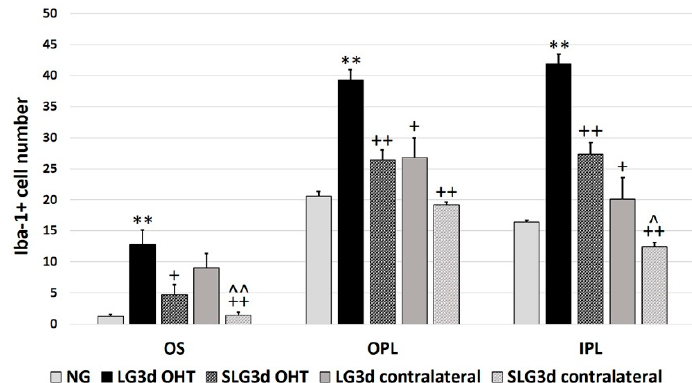
Figure 5. Number of Iba-1 + cells at day 3 after ocular hypertension (OHT) induction in the photoreceptor outer segment layer (OS), outer plexiform layer (OPL), and inner plexiform layer (IPL). Histograms show the mean number (± standard deviation, SD) of Iba-1 + cells per area of 0.1502 mm 2 . Abbreviations: Naïve age-matched control (NG), lasered group contralateral (LG3d contralateral), lasered group ocular hypertension (LG3d OHT), lasered group contralateral + saffron (SLG3d contralateral), lasered group ocular hypertension + saffron (SLG3d OHT). Statistical significance indicators: ** p < 0.01; vs. NG. + p < 0.05, ++ p < 0.01; vs. LG3d OHT. ^ p < 0.05, ^^ p < 0.01; vs. LG3d contralateral.